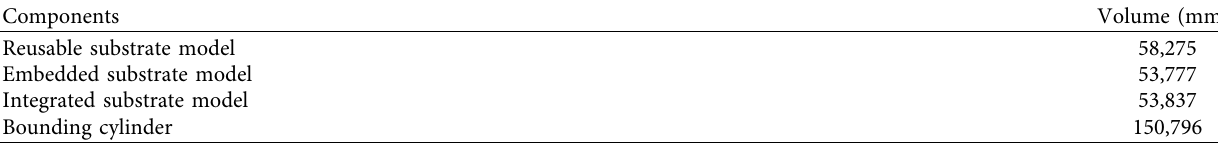
Table 3: Volume of the fabricated components.